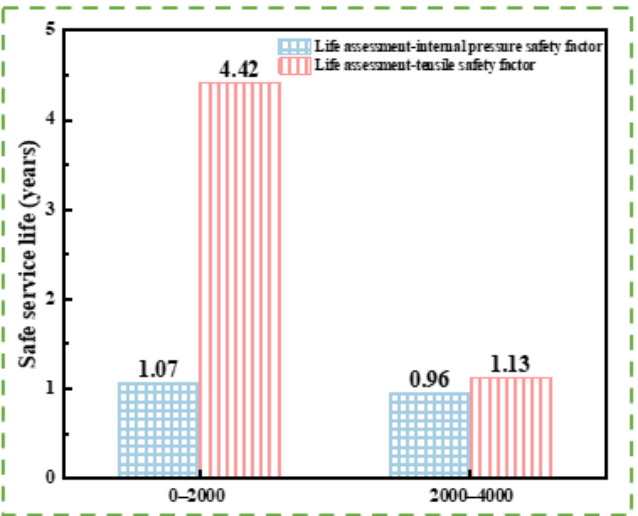
Figure 19. Residual tensile strength of T95 steels considering pitting corrosion: 0–2000 m; 2000–4700 m ( a , c : Residual tensile strength and Residual internal pressure strength in gas phase; b , d : Residual tensile strength and Residual internal pressure strength in liquid phase).